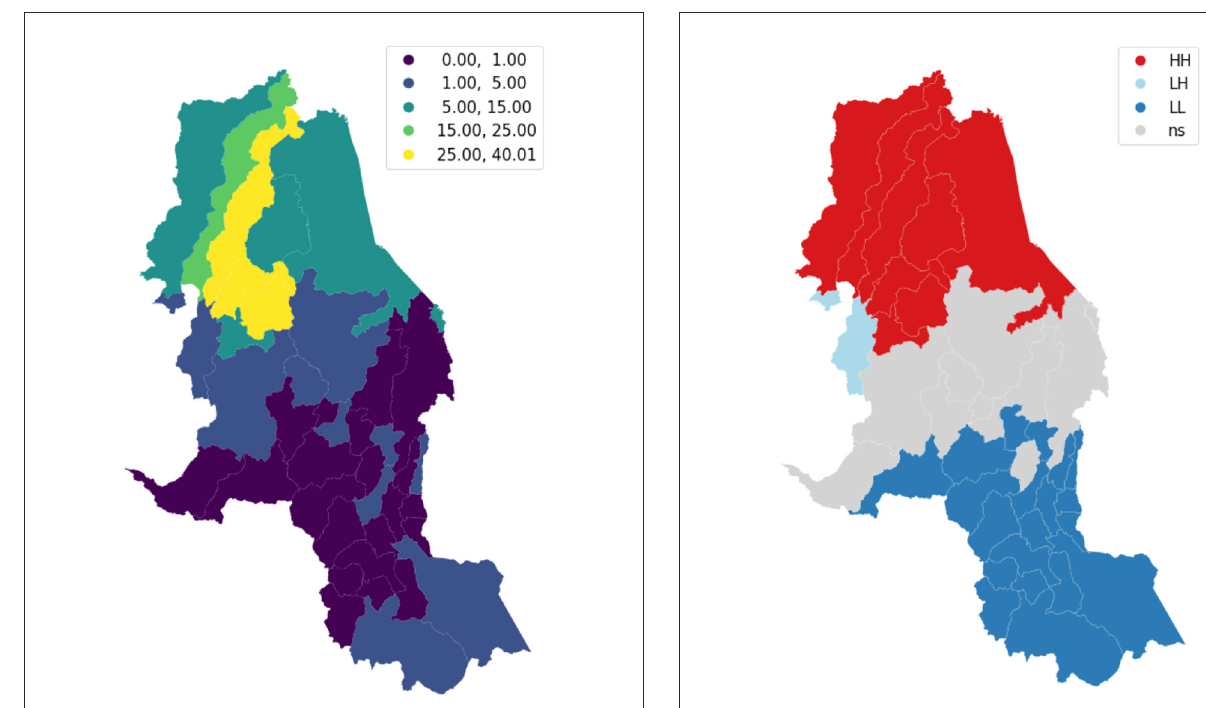
FIGURE10 LISA clusters map—Focus on Norte de